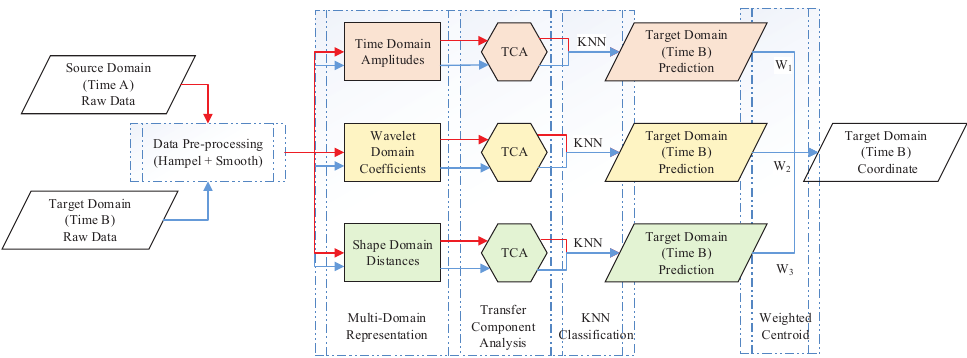
Figure 3. Systematic method